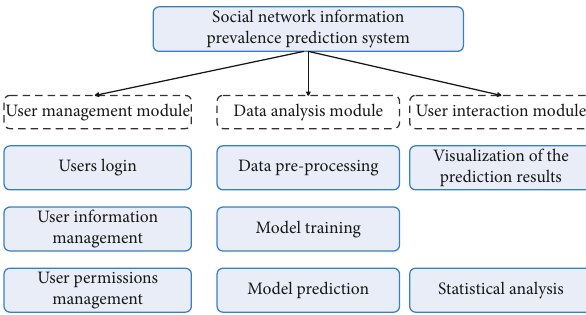
Figure 5: System function module diagram.